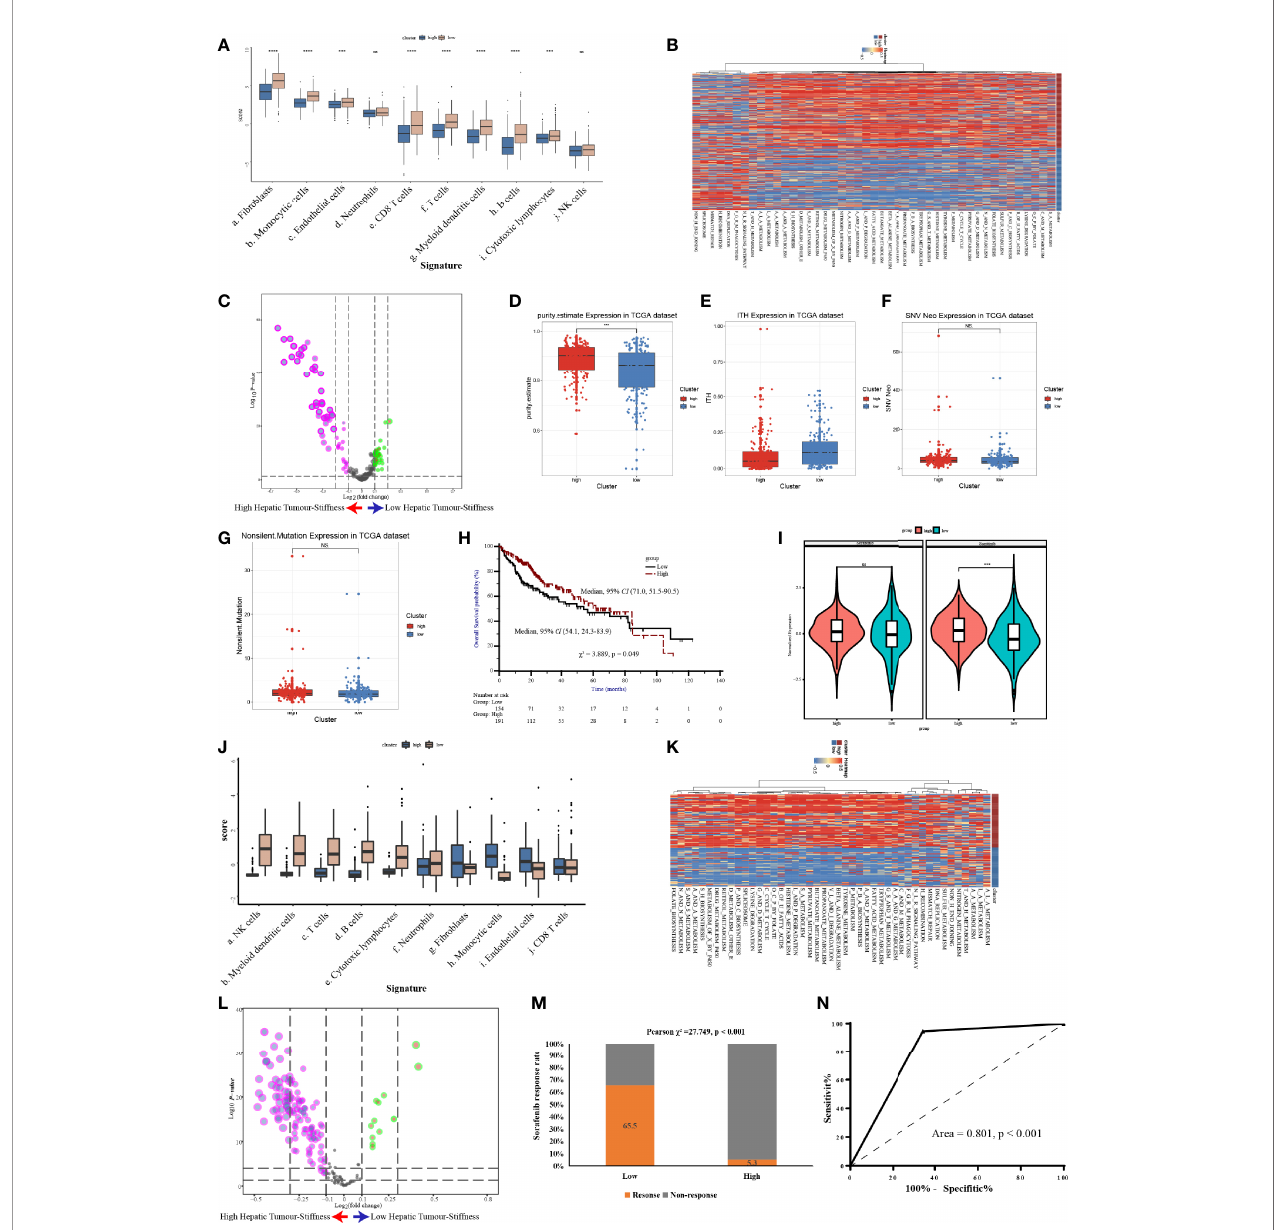
FIGURE 7 | Validation of the high stiffness signature in TCGA-LIHC and GSE109211 datasets. (A) Boxplots of cell in fi ltration, as calculated by the Microenvironment Cell Populations-counter (MCP-counter), among tumors with high and low stiffness from The Cancer Genome Atlas Liver Hepatocellular Carcinoma (TCGA-LIHC) cohort. (B, C) Heatmap (B) and volcano plot (C) comparing differences in the Kyoto Encyclopedia of Genes and Genomes (KEGG) pathways between tumors with high and low stiffness in the TCGA-LIHC cohort. (D – G) Boxplots of tumor purity (D) , intratumoral heterogeneity (ITH) (E) , neoantigen (F) , and tumor mutation burden (G) in the 4 studied histone modi fi cation patterns of the TCGA-LIHC cohort. (H) Kaplan-Meier curves of overall survival in the TCGA-LIHC cohort according to tumor stiffness. (I) Violin plot of the estimated IC50 value of sorafenib and sunitinib calculated based on the Genomics of Drug Sensitivity in Cancer database among tumors with high or low stiffness in the TCGA-LIHC cohort. (J) Boxplots of cell in fi ltration levels calculated by the MCP-counter among tumors with high and low stiffness in the GSE109211 cohort. (K, L) Heatmap (K) and volcano plot (L) comparing differences in KEGG pathways between tumors with high and low stiffness in the GSE109211 cohort. (M) Bar charts summarizing the proportions of patients with different sorafenib responses across different tumor stiffness groups in the GSE109211 cohort. (N) Receiver operating characteristic curves of treatment response predictions of sorafenib according to the tumor stiffness signature in the GSE109211 cohort. NS means not-sigini fi cant (without statistical difference); *** means p value < 0.001; **** means p value <